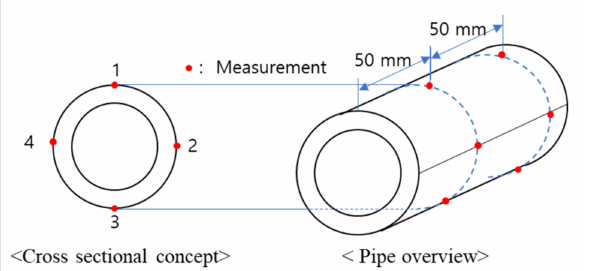
Figure 4. Location of the ultrasonic velocity and microstructural analysis